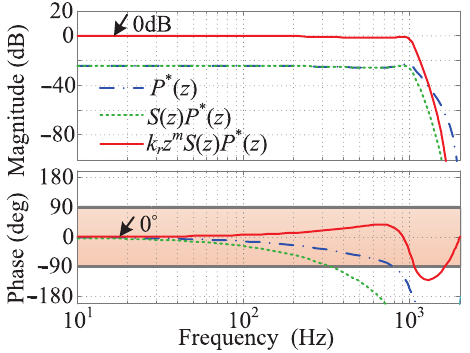
Figure 7. Bode diagrams of P ∗ ( z ) , S ( z ) P ∗ ( z ) , and k r S ( z ) z m P ∗ ( z )